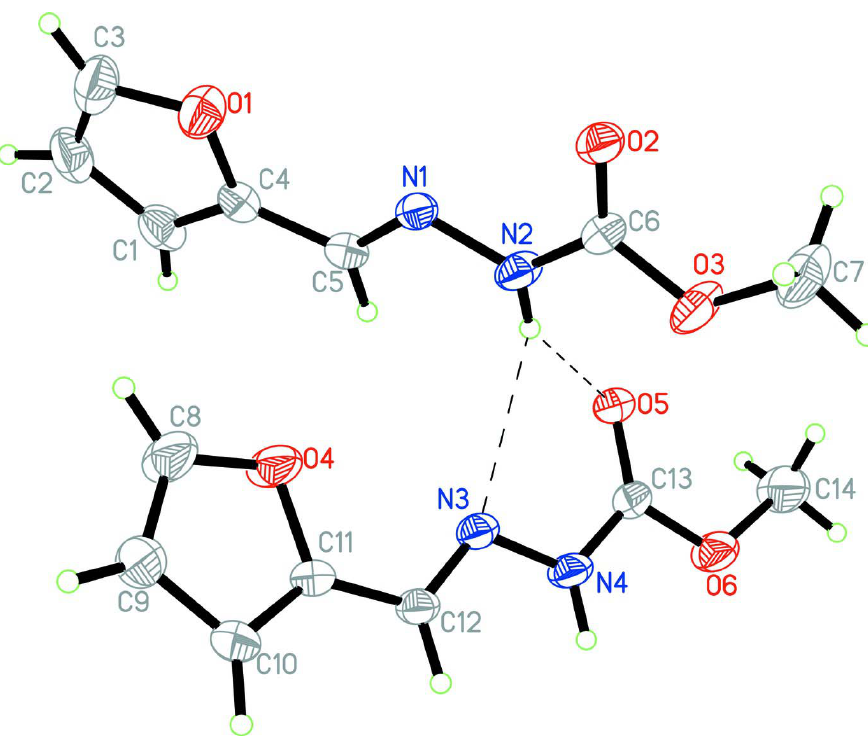
Figure 1 The asymmetric unit of the title compound. Displacement ellipsoids are drawn at the 50% probability level. Dashed lines indicate hydrogen